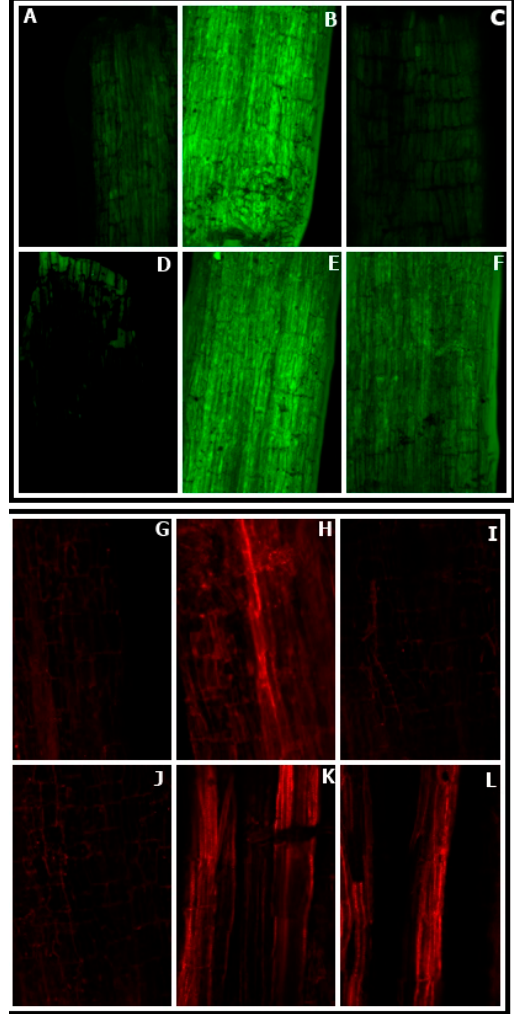
Figure 9. Confocal microscopic images of H 2 O 2 formation in roots using H2DCFDA staining ( A–F ) and cell viability test ( G–L ) by propidium iodide staining, was performed on 30 days old roots of Indian mustard ( Brassica juncea L.). Plants were grown with / without Cu stress and treated during pre-germination for 3 h with water, SNP, FCy (SNP analogue) and SNP + cPTIO (cPTIO as a specific NO-scavenger). Control: A and G ; B and H : Cu; C and I : SNP; D and J : SNP + Cu; E and K : FCy + Cu; F and L : SNP + cPTIO + Cu.